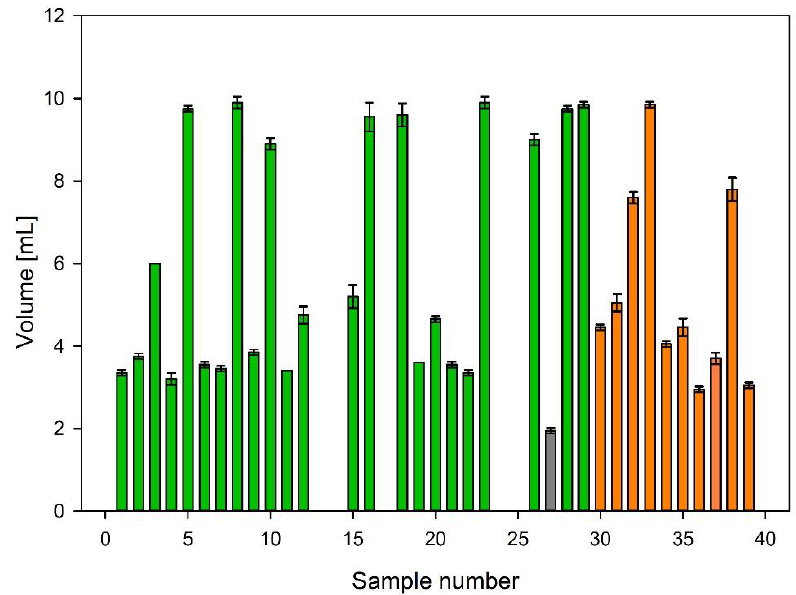
Figure 4. Volume of 1 g of bentonite after 48 h in a 1% citric acid solution. Green bars represent wine-fining agents, orange bars are pharma/beauty products, and the grey bar is the desiccant. Missing bars indicate unavailable products that were not included in the study.